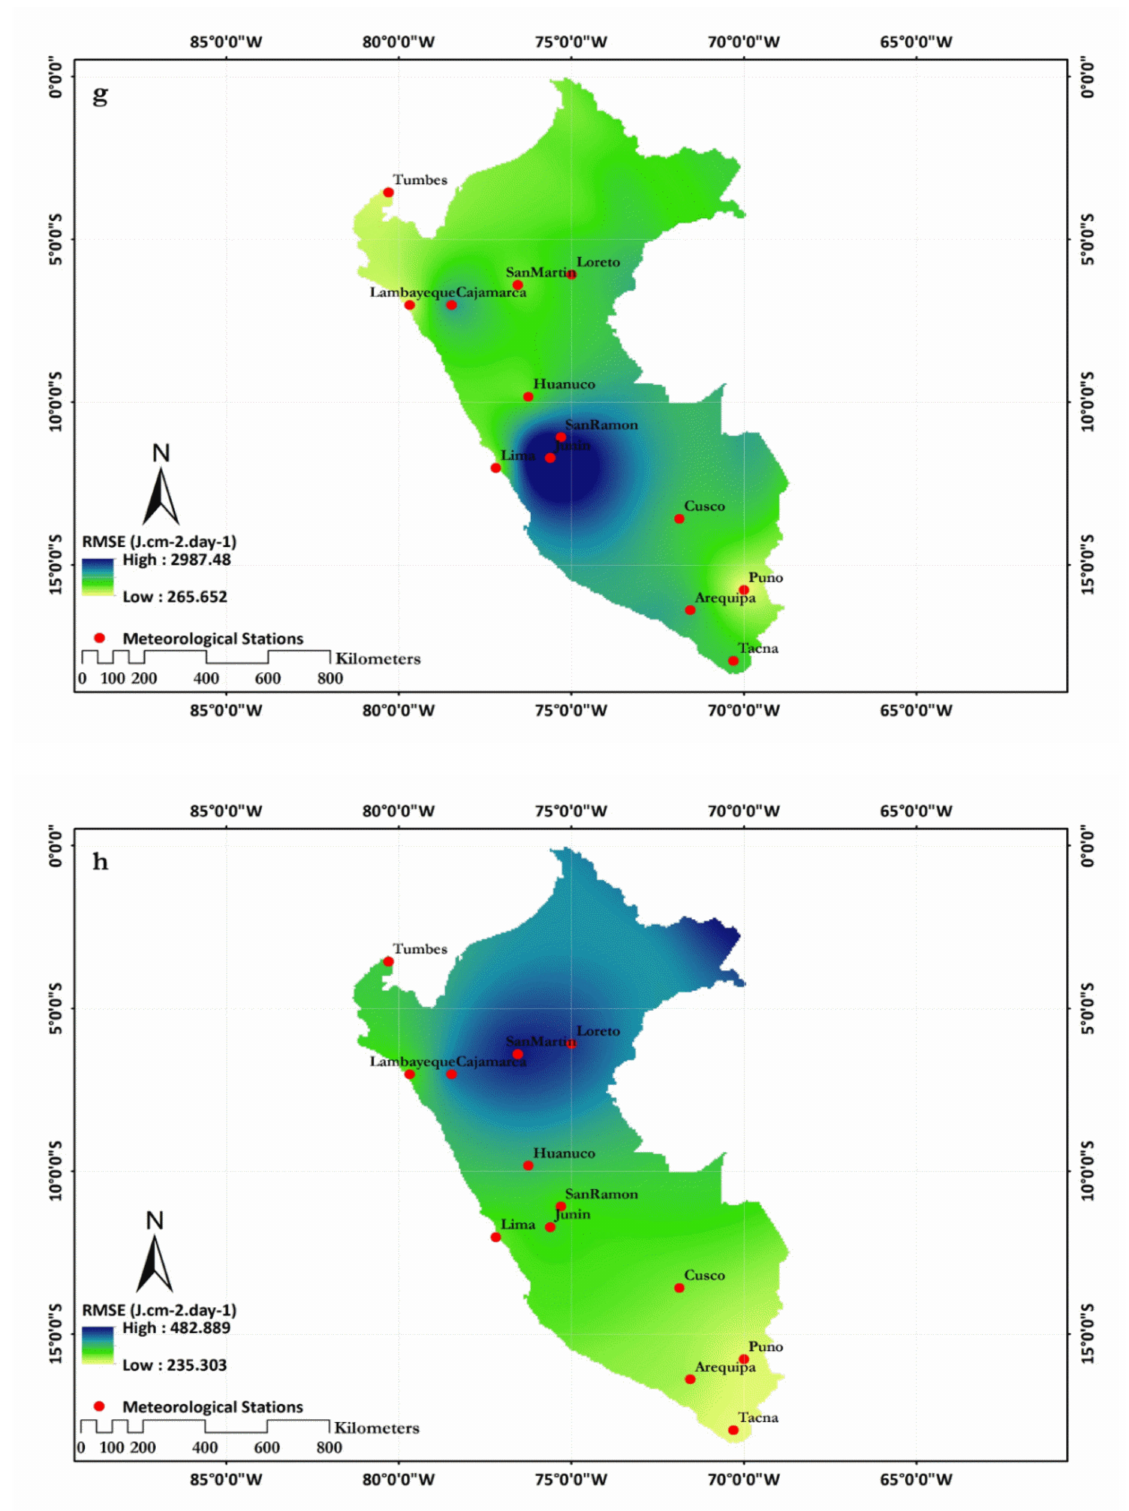
Figure 16. Interpolated spatial distribution of error in solar radiation estimation at all stations using ( a ) Hargreaves- Samani [30] and ( b ) Samani [31] models ( c ) Annandale et al. [32] and ( d ) Chen et al. [33] models ( e ) Wu et al. [36] and ( f ) Jahani et al. 1 [2] models ( g ) Jahani et al. 2 [2] and ( h ) proposed